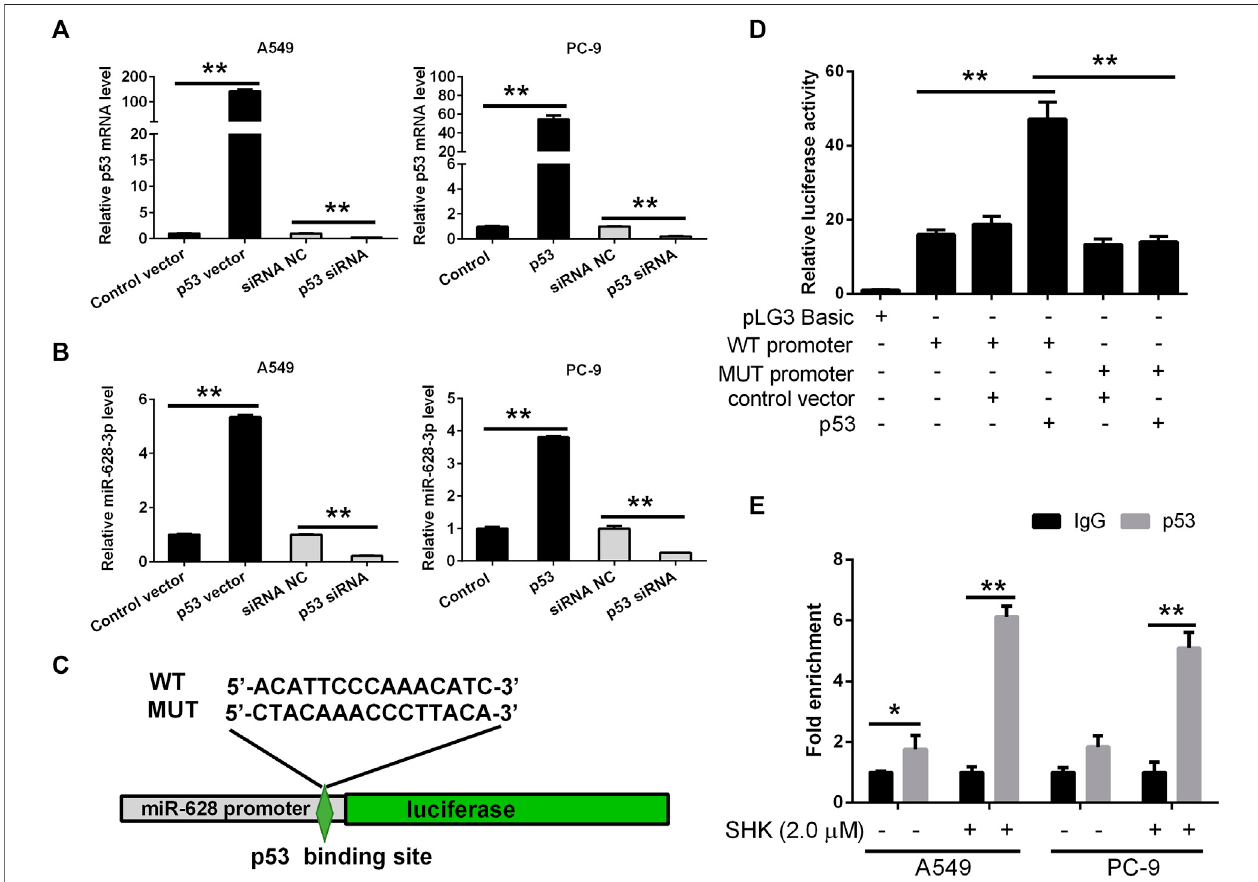
FIGURE 6 | miR-628-3p is a direct transcriptional target of p53. After 24 h of p53 overexpression or interference, the expression levels of (A) p53 mRNA and (B) miR-628-3p were detected by qRT-PCR, respectively; (C) miR-628 reporter plasmid in which the pre – miR-628 promoter, either wild type or mutagenized in the p53 binding sites (depicted schematically), was cloned into pGL3 vector upstream of the luciferase reporter gene. (D) pGL3 luc reporter plasmid itself (pGL3 Basic) or pGL3 plasmid containing the WT or MUT promoter region of pre – miR-628, p53-expressing plasmid (p53), or its control vector was transfected into 293T cells by Lipofectamine 3000 as indicated. The interaction between p53 and the promoter region of pre – miR-628 was then determined by dual-luciferase assays. (E) A549 and PC-9 cells were untreated or treated with 2.0 μ M SHK; after cell lysis, the chromosomal DNA was subjected to ChIP assays by incubating with mouse anti-human p53 antibody or normal mouse IgG. The DNA was recovered and subjected to qPCR to amplify the binding sites ofthe pre – miR-628promoter region using speci fi cprimers. Dataarepresentedasrelativeenrichmentnormalized tocontrolIgG.Allmeasurements werecarried outintriplicates, anddataaregivenasmean ± SD( n (cid:2) 3).* p ≤ 0.05, ** p ≤